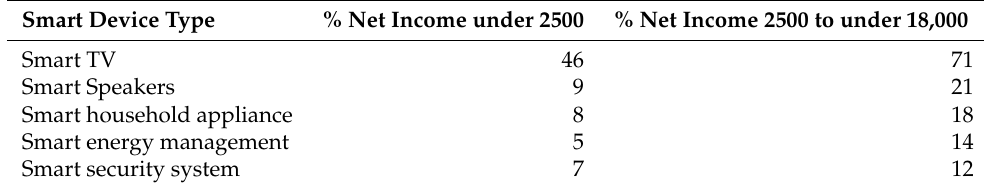
Table 3. Household equipped with smart devices and systems, 1 January